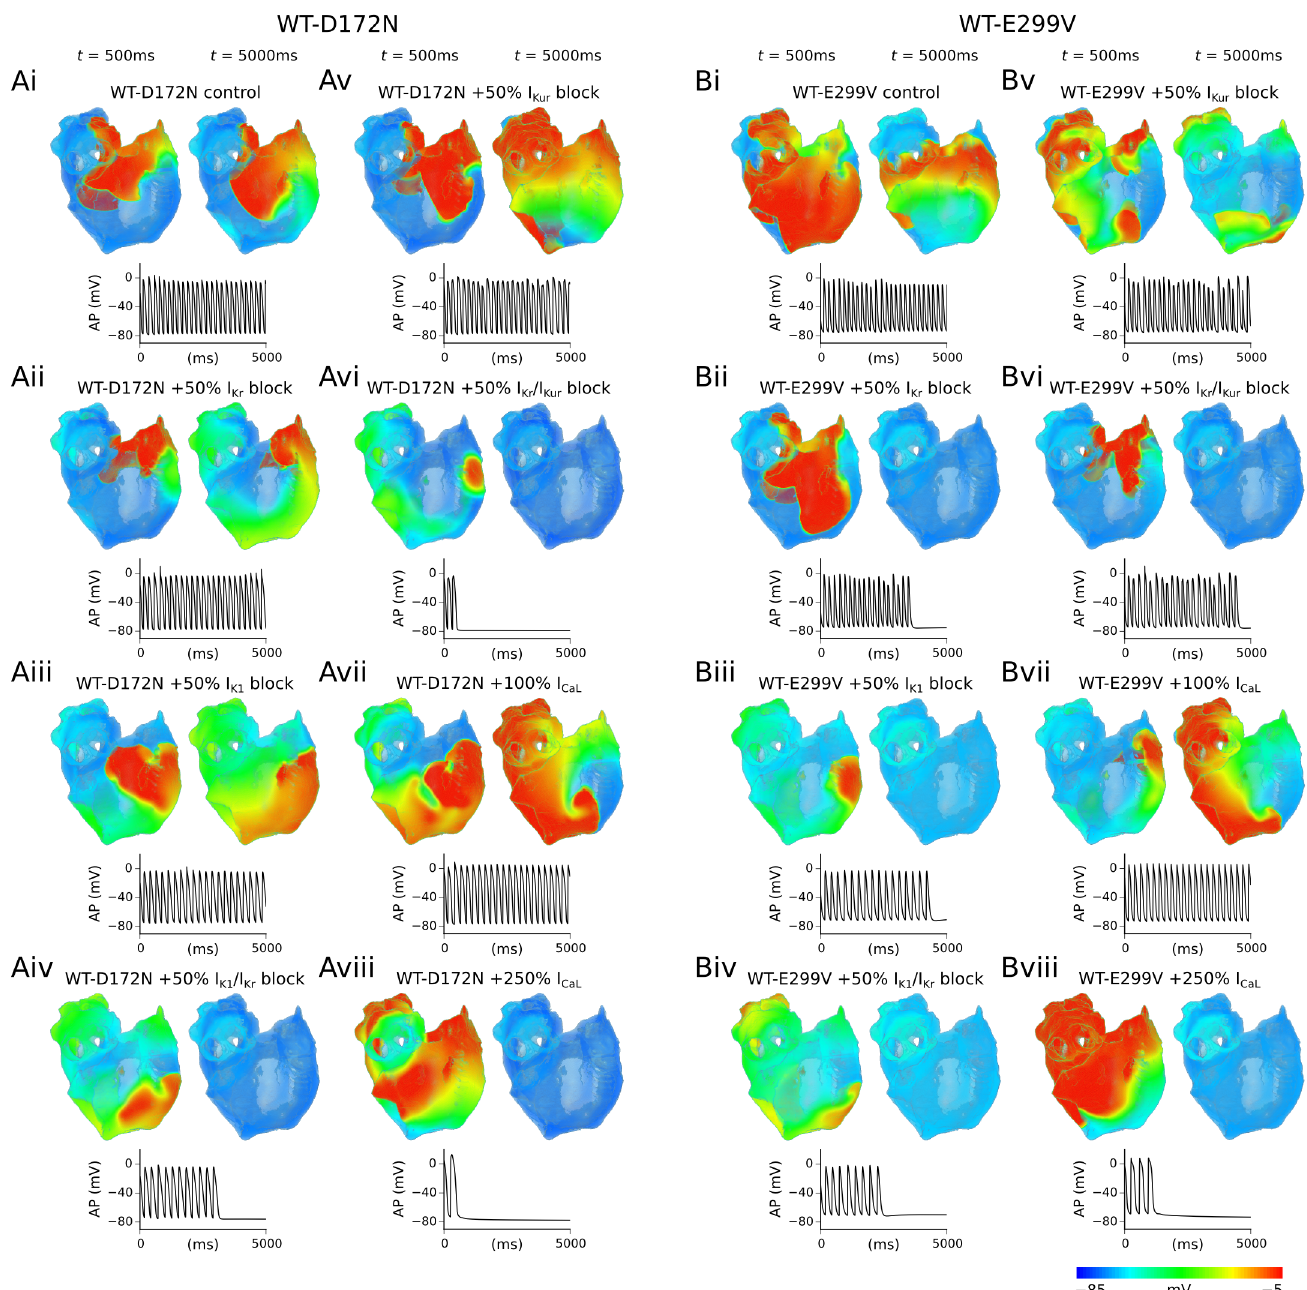
Fig 7. Simulated drug effects in 3D virtual human atria. Snapshotsof simulateddrug effects on re-entrant scroll waves in WT-D172N (A) and WT-E299V (B) conditions. For both mutation conditionspanels correspond to the followingcases: control (i), 50% I Kr block (ii), 50% I K1 block (iii), combined50% I K1 +I Kr block (iv), 50% I Kur block (v), combined50% I Kr +I Kur block (vi), 100%increase in I CaL (vii), and 250% increasein I CaL (viii). For each case, two columns are shown which correspond to t = 500 ms and t = 5000 ms after initiationof re-entry, and corresponding APs extracted from the RA are shown